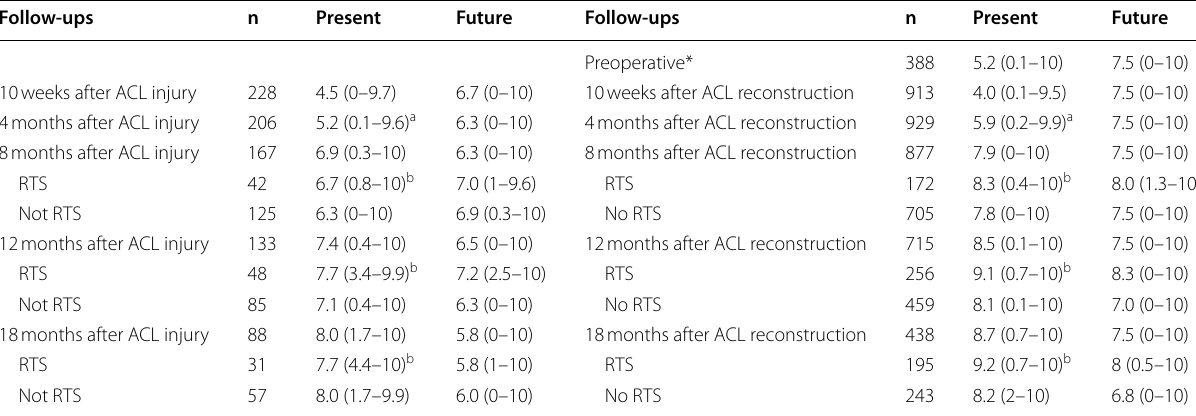
Table 4 Comparative scores (median and min-max) of the subscales present and future of the K-SES return to sport